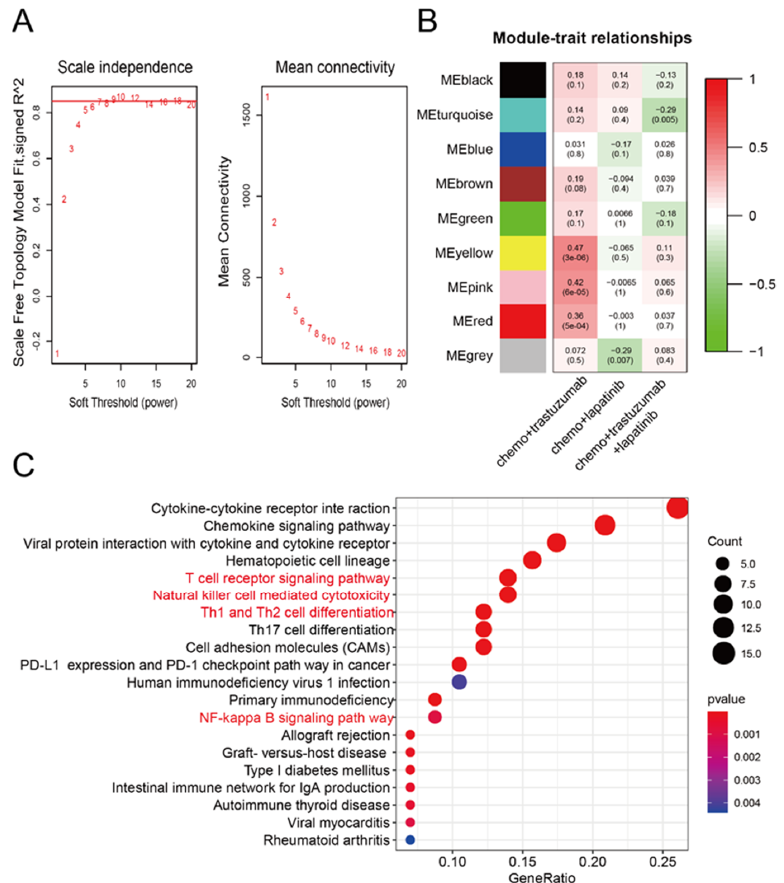
Figure 1. Construction of the gene coexpression network from patients exposed to neoadjuvant anti- HER2 therapies. ( A ) Selection of the soft-thresholding powers. The left panel shows the scale-free fit index versus the soft-thresholding power. The right panel displays the mean connectivity versus soft- thresholding power. The digital numbers stand for different β (soft-thresholding power) parameter and the red horizontal line represents the cutoff (0.9) of scale-free topology index. ( B )